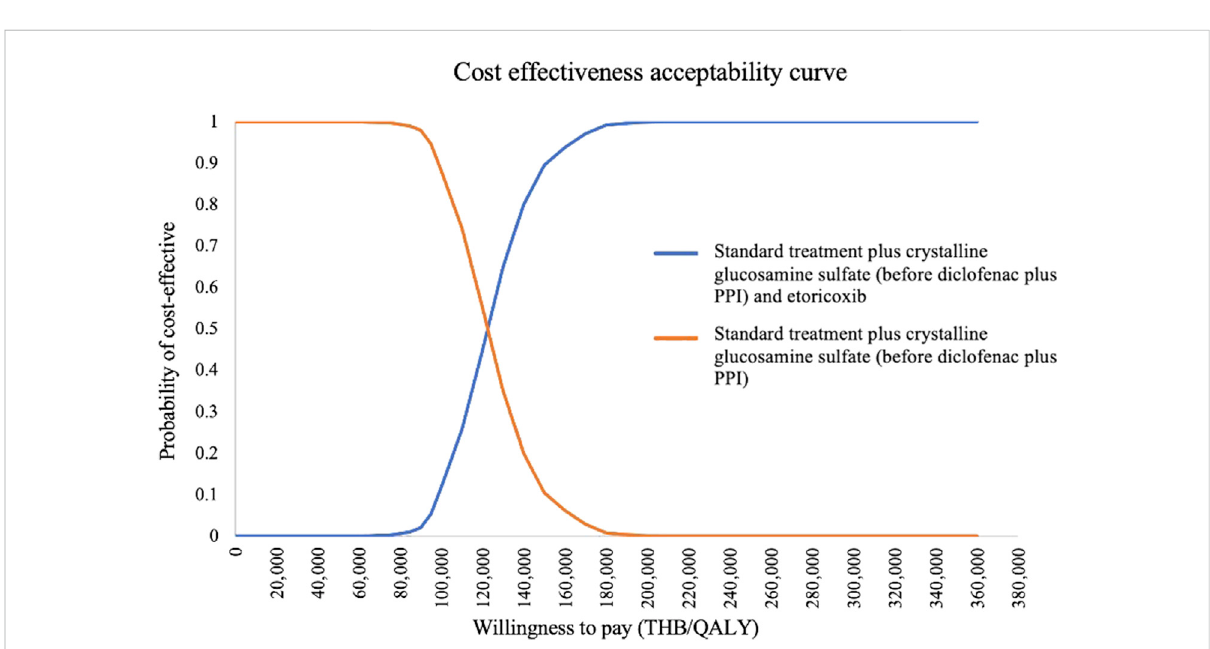
FIGURE 4 Cost-effectivenessacceptablitycurveforstandardtreatmentpluscrystallineglucosaminesulfate(beforediclofenacplusPPI)andetoricoxibvs. standard treatment plus crystalline glucosamine sulfate (before diclofenac plus PPI). PPI, proton pump inhibitors; QALYs, quality-adjusted life-years; THB, Thai